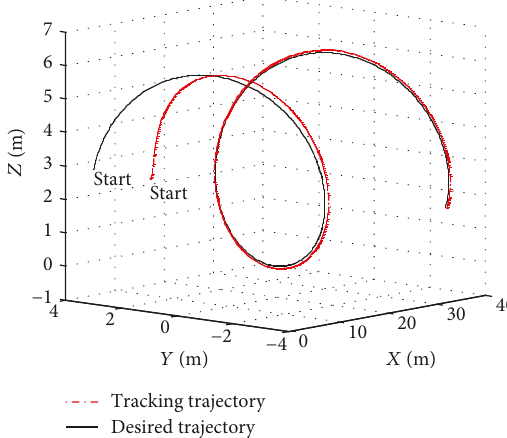
Figure 6: Simulation result using backstepping only.